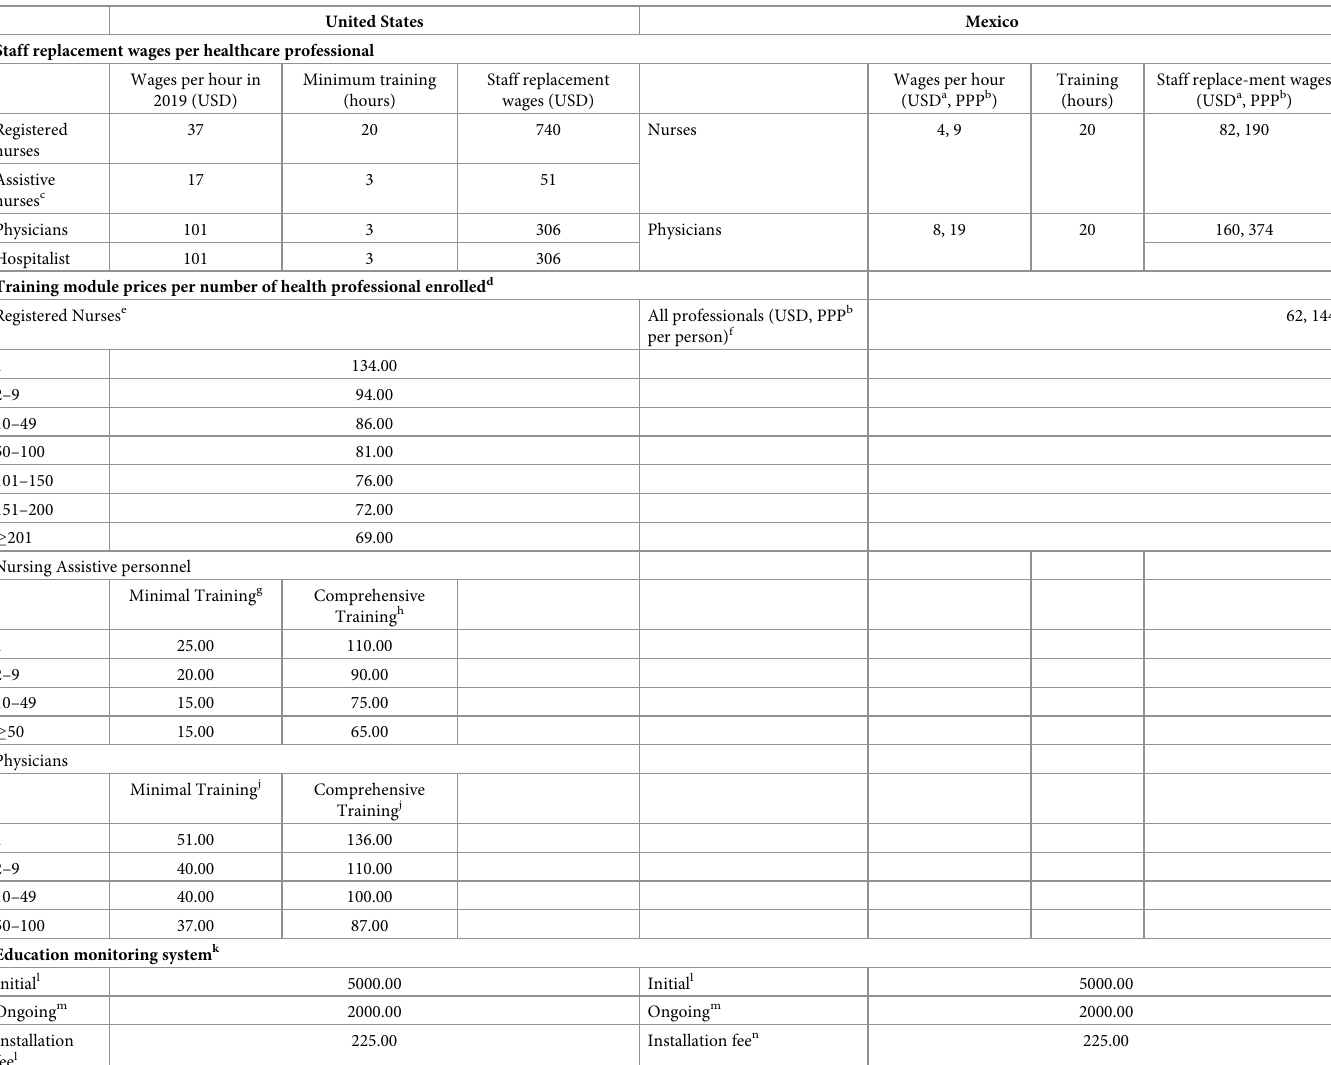
Table 5. Costs (in USD) of the 3 factors used for estimating total BFHI training costs. United